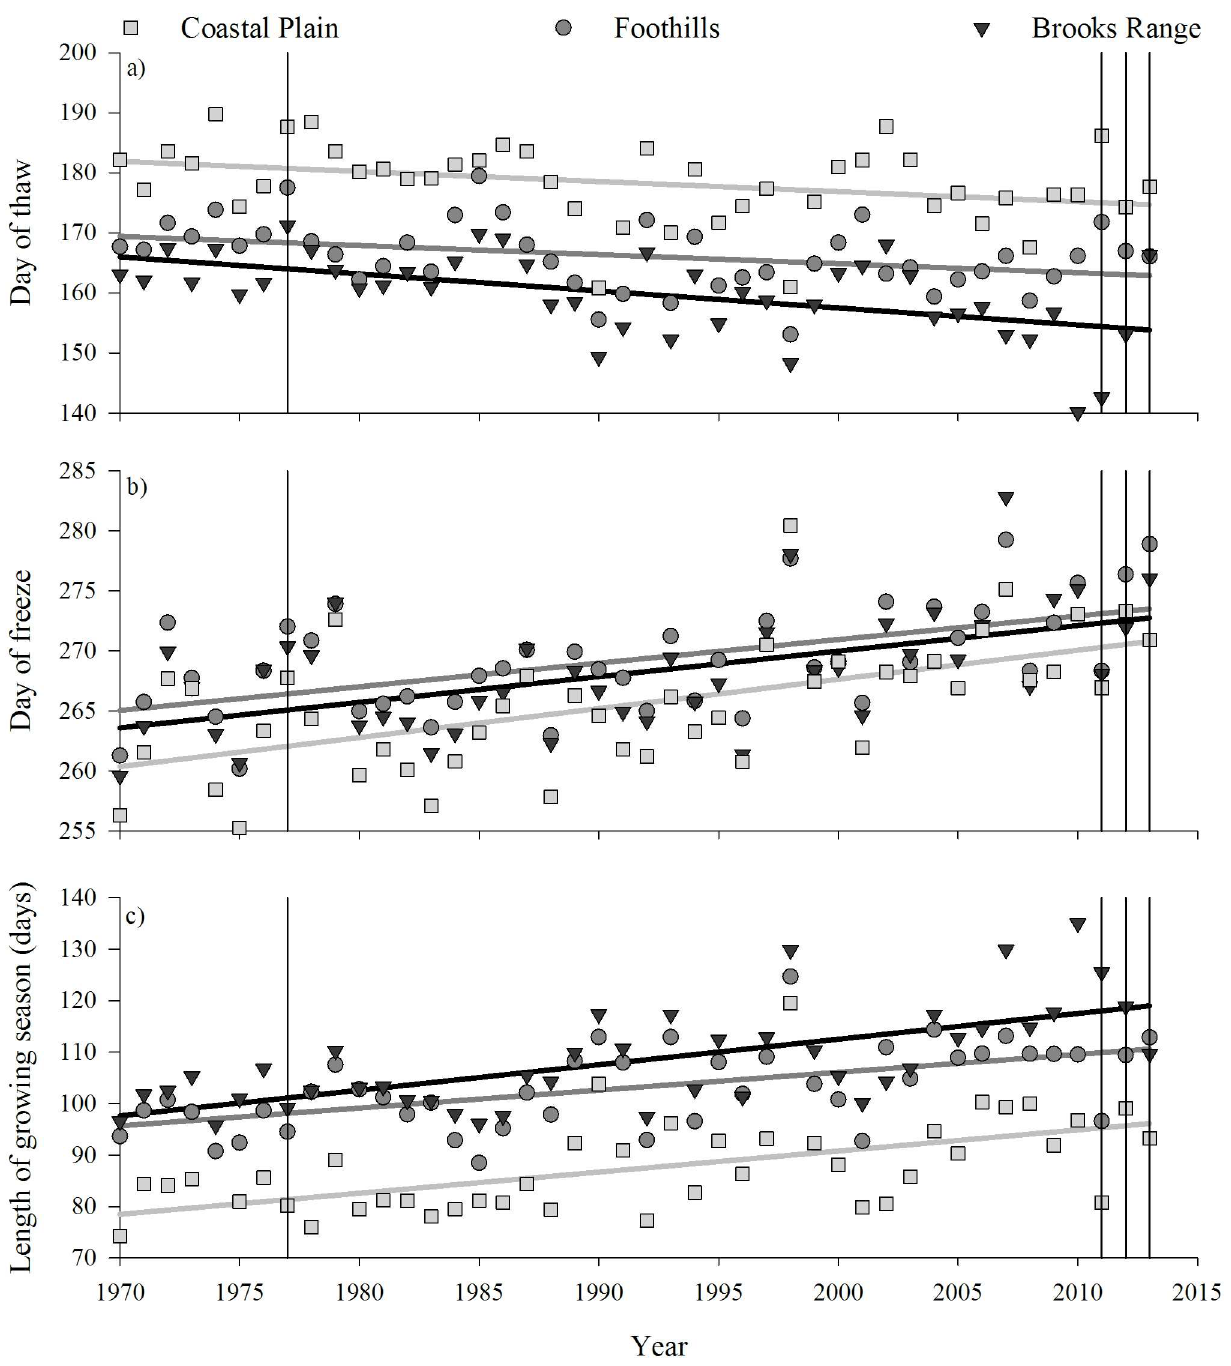
Fig 2. Estimatesof the a) day of thaw, b) day of freeze, and c) length of the growing season in three ecoregions (Coastal Plain, Foothills, and Brooks Range) along the Dalton Highway, North Slope of the Brooks Range, Alaska;vertical lines denote yearsof forage sampling; and the confidence intervals (95%) of all slopes did not include zero ( r 2 = 0.11–0.44).